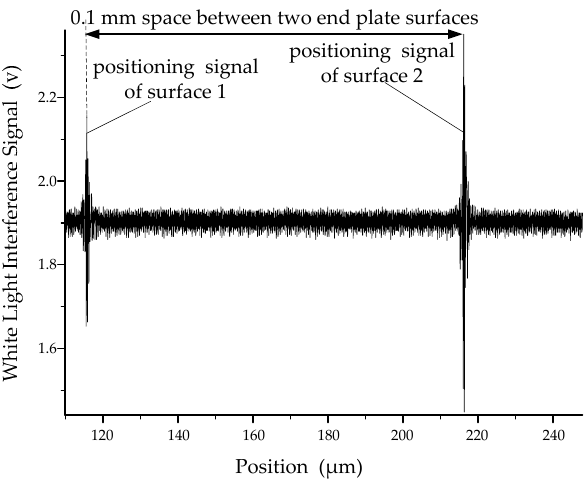
Figure 3. Positioning signal of 0.1 mm step surface.